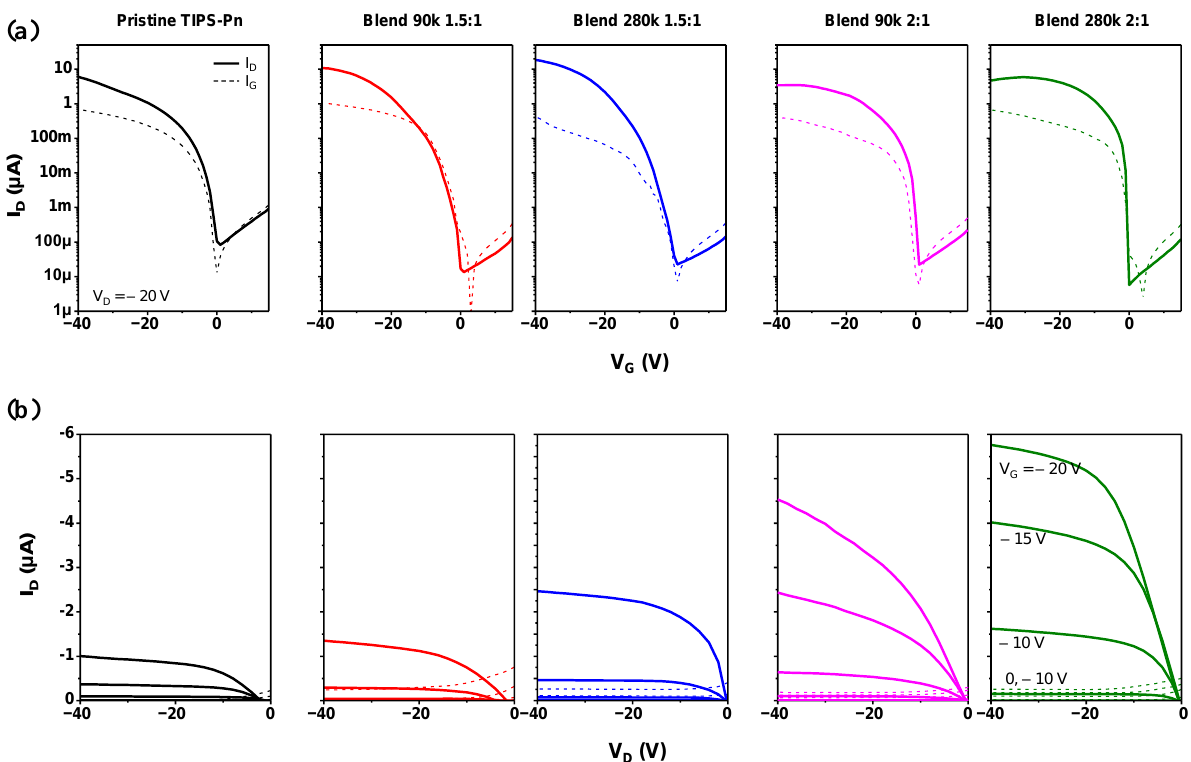
Figure 2. ( a ) Transfer and ( b ) output characteristics of the fabricated TFTs under dark conditions. Table 1. Electrical properties of the TFTs fabricated with pristine TIPs-Pn, Blend 90k 1.5:1, Blend 280k 1.5:1, Blend 90k 2:1, and Blend 280k 2:1 extracted from the transfer characteristics under dark